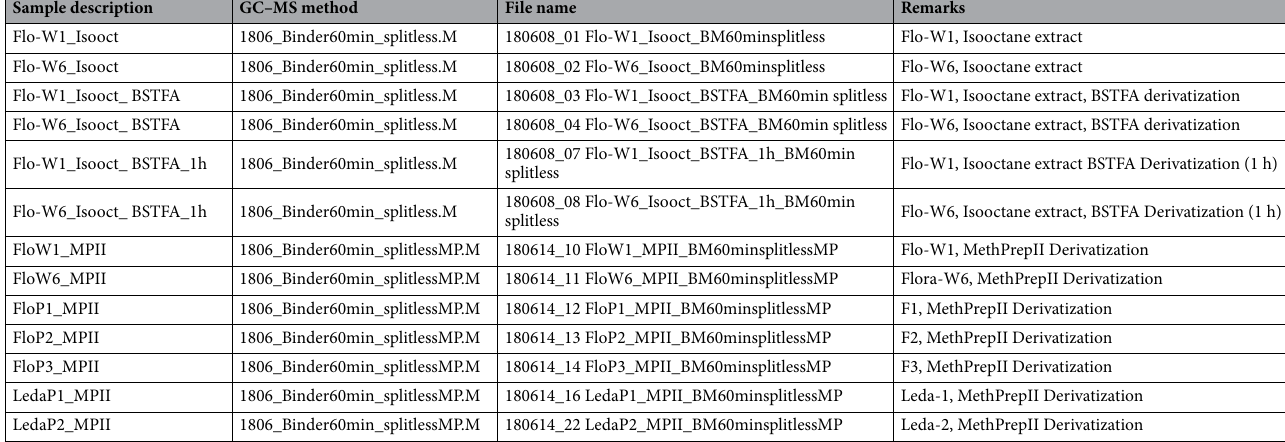
Table 4. Overview of the samples analyzed by GC–MS, GC–MS method and information on sample preparation (extraction or derivatization) and GC–MS file